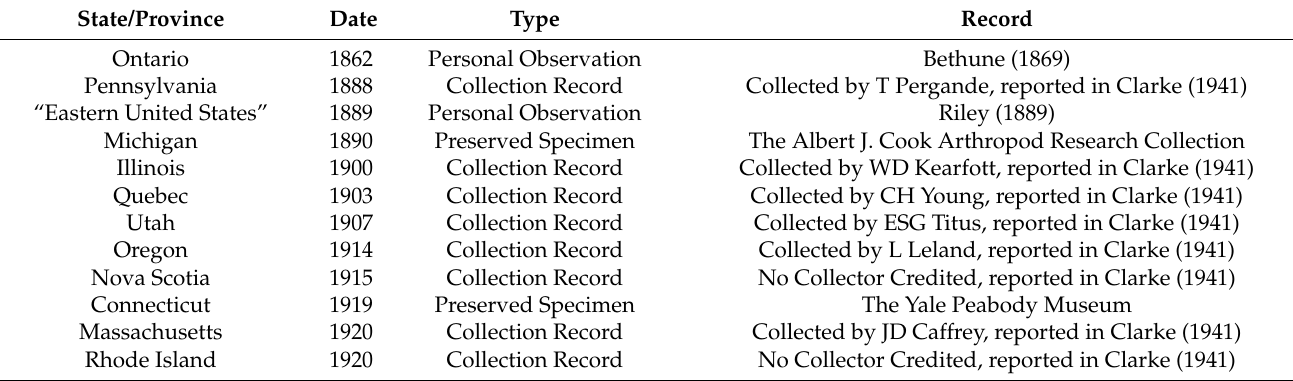
Table 3. Reconstruction of the establishment of D. radiella across the USA and Canada with the use of literature and museum records.